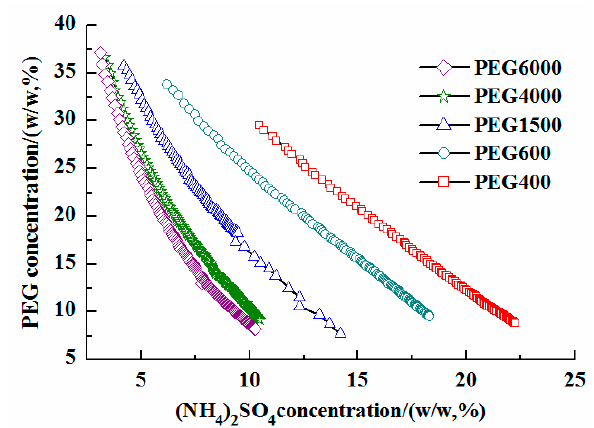
Figure 2. Phase diagrams of different molecular weight PEG/(NH 4 ) 2 SO 4 aqueous two-phase systems.